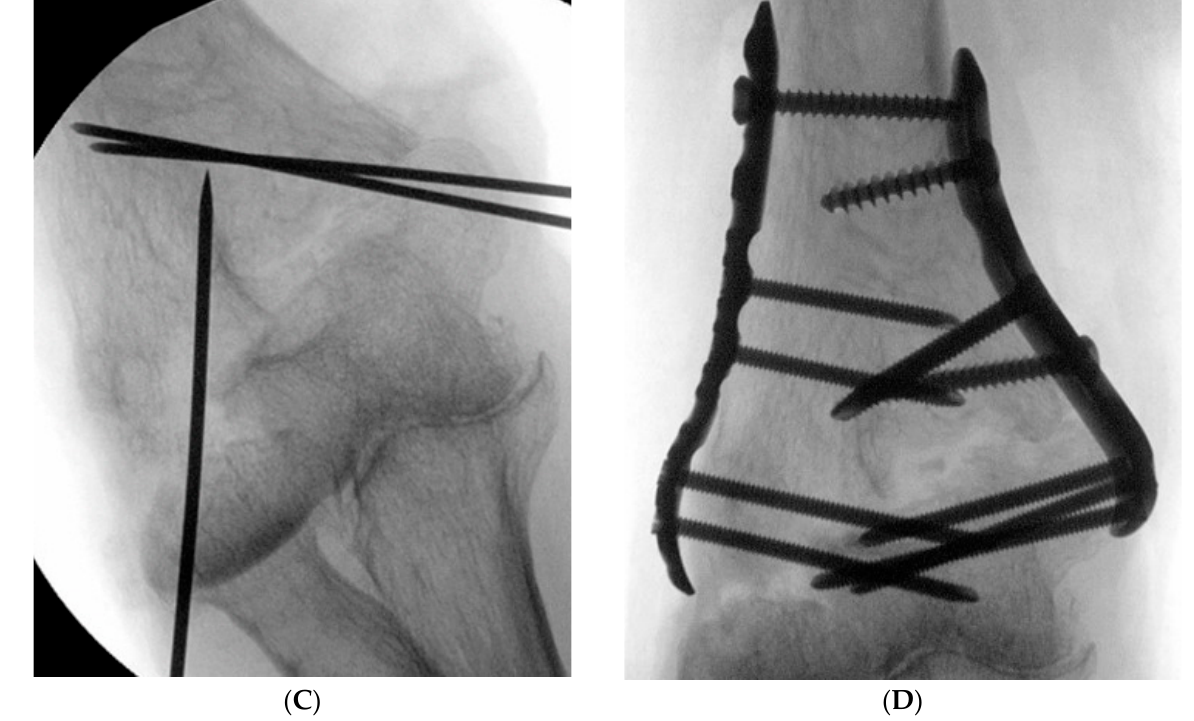
Figure 2. Dual incision ( A ) medial approach, identification of ulnar nerve (arrow), temporary fixation using two Kirschner wires, ( B ) lateral incision, temporary fixation using one Kirschner wire, ( C ) intraoperative C-arm radiograph, ( D ) orthogonal plate fixation.